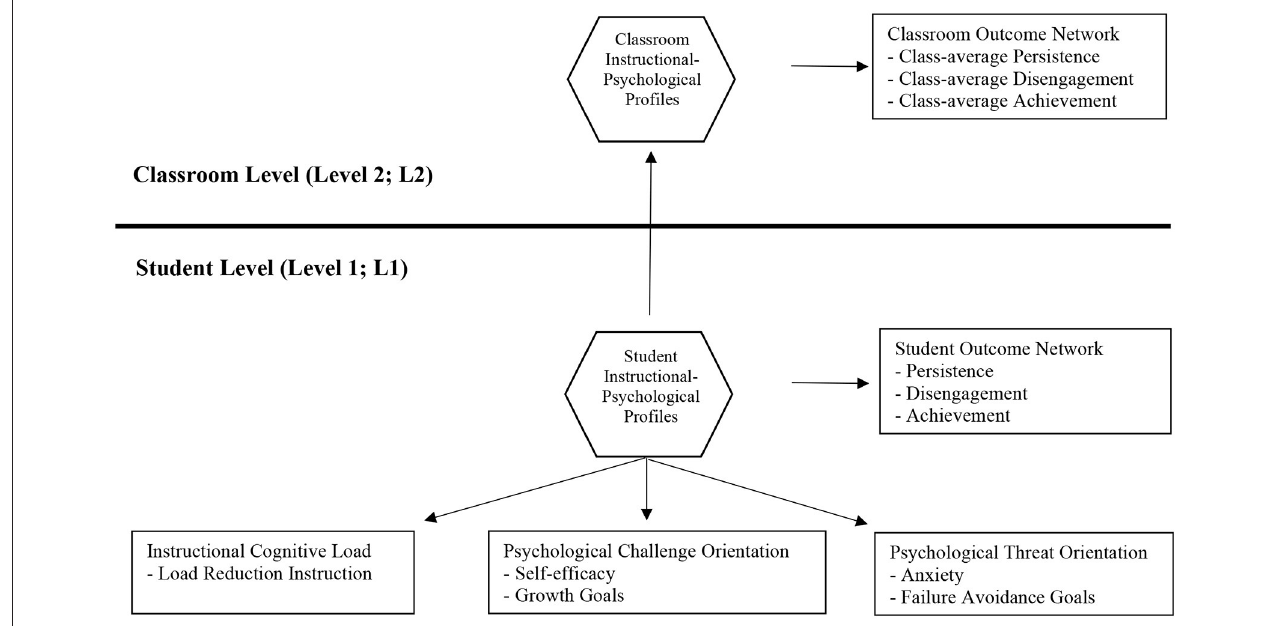
FIGURE 1 | Hypothesized models tested in the study at the student- and